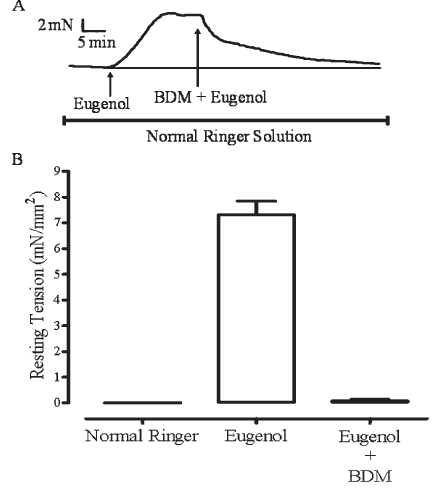
Figure 5. Force-pCa relationship of Triton-skinned atria trabecu- lae. Force was normalized to F max . Data are reported as average force±SE. The values of N and Ca 2++ 50 in the absence and in the presence of eugenol were 1.37±0.03, 1.60±0.2 and 1.18±0.02, 1.24±0.17 m M, respectively